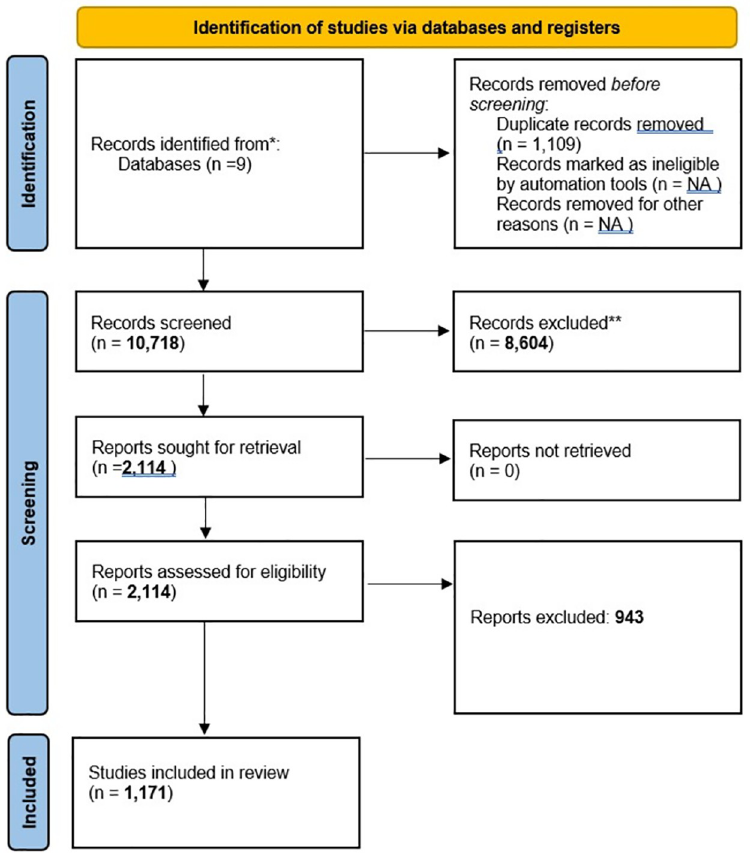
Fig 1. Flow diagram for systematic reviews of HIV prevalence, the HIV treatment cascade (HIV testing, linkage to care, treatment, viral suppression) and experienced violence (physical, sexual, and intimate partner) among among female sex